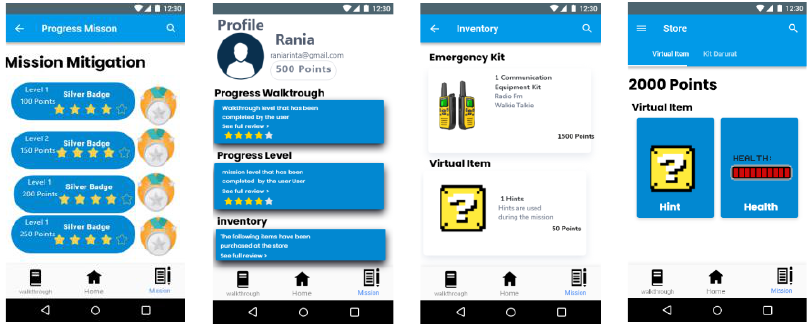
Fig. 7. Profile, inventory, store, and level of